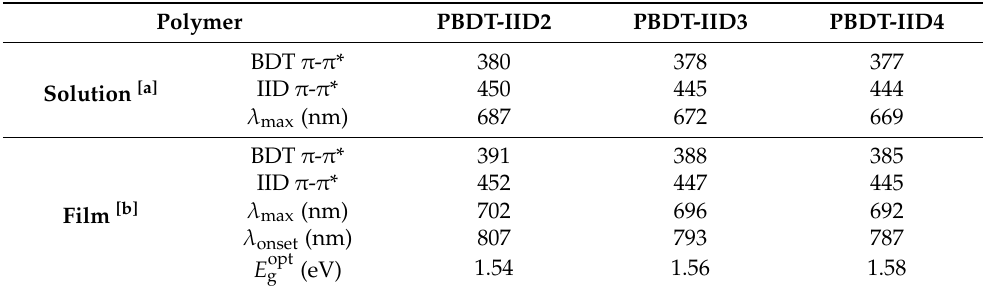
Table 2. The optical properties of the PBDT-IID solutions (in THF) and thin